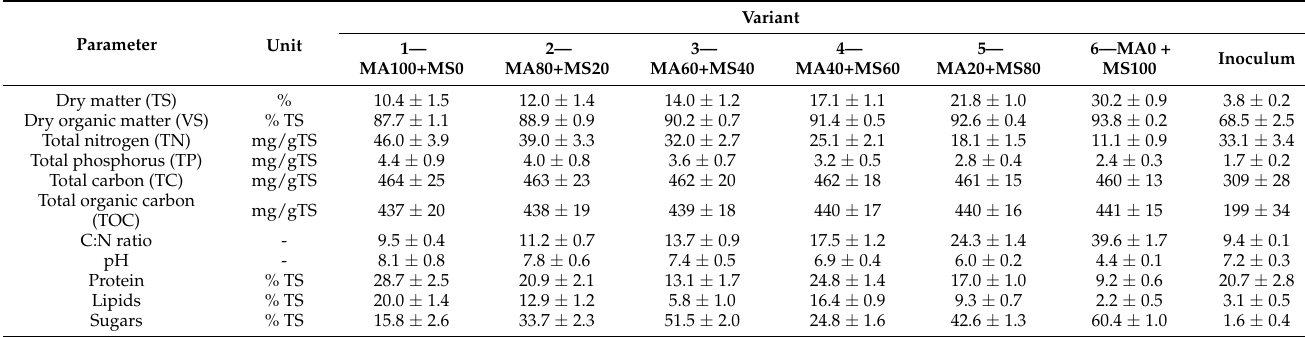
Table 1. Profile of the feedstock digested in different variants and anaerobic sludge (inoculum).